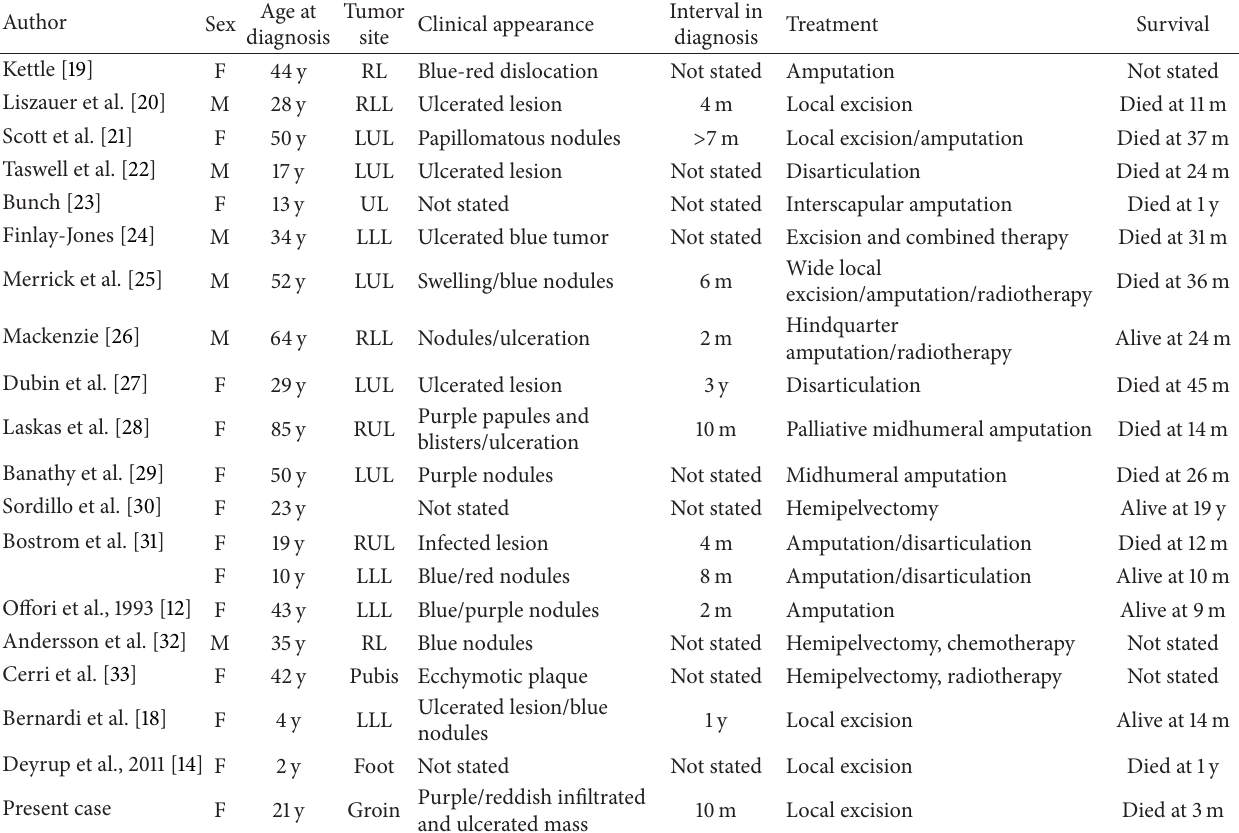
Table 1: Clinical features of patients with cutaneous angiosarcoma associated with congenital lymphedema described in the